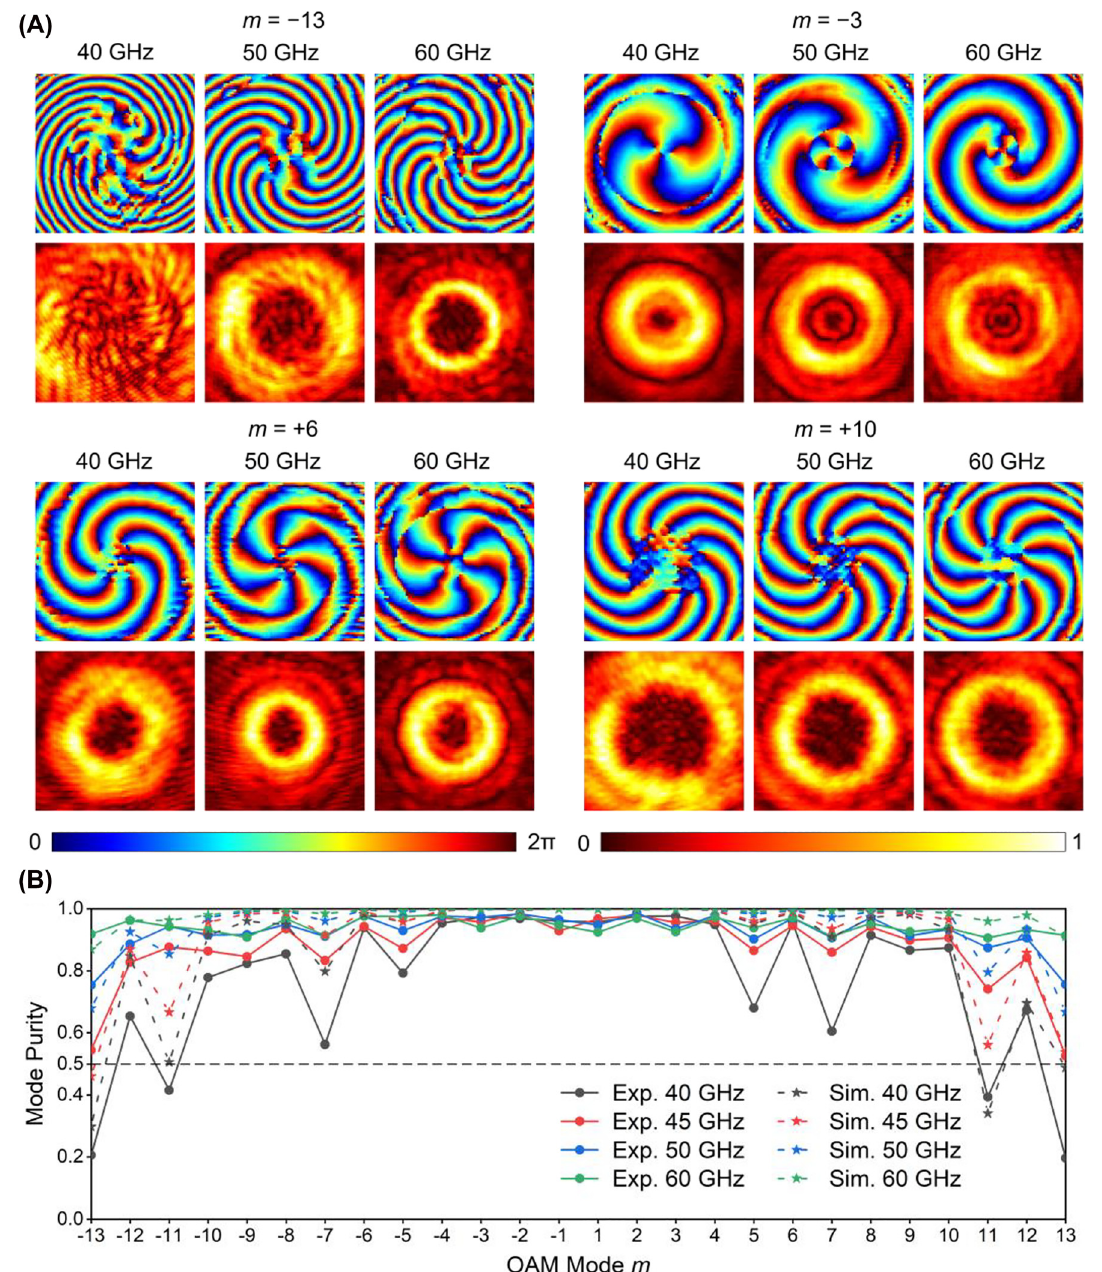
Figure 5: Broadband results of the proposed method based on cascading three BVGs. (A) Experimentally measured phase profilesand intensity distributions at 40, 50, and 60 GHz, where four typical vortex modes are presented. Thephasepro fi lesareplottedinjetcolorbarandtheamplitudedistributionsareplottedinhotcolorbar.(B)Modepurityofthe26vortexmodes at different frequencies obtained by simulation and experimental